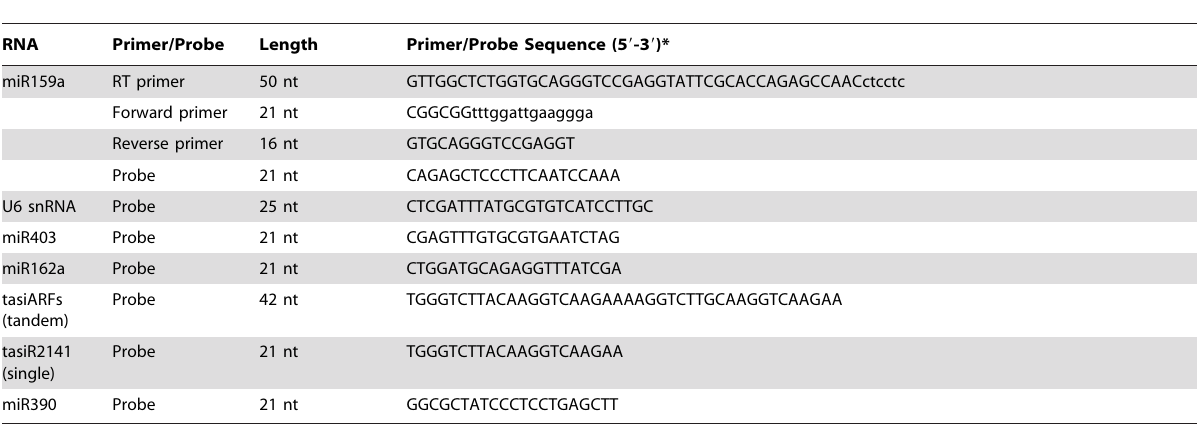
Table 1. The primer and probe sequences used for detecting specific miRNAs and other small RNAs.